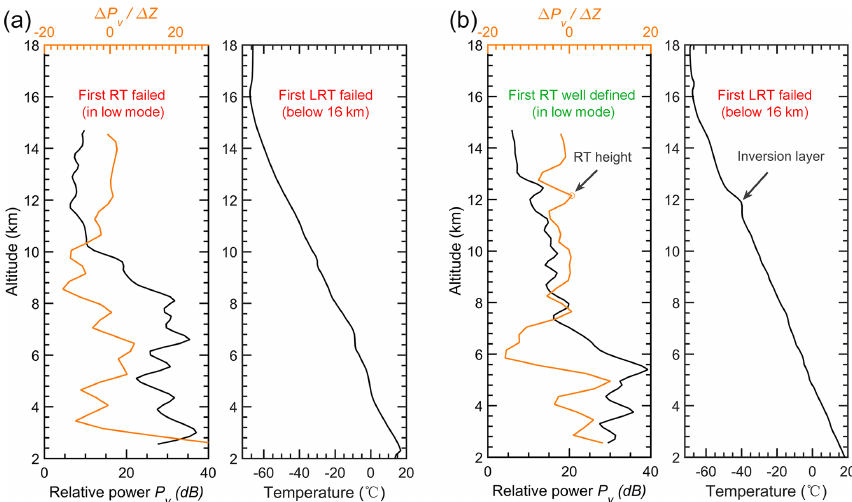
Figure 12. Example profiles of radar echo power and radiosonde temperature in which (a) both the RT and LRT definitions fail due to the continuing decrease in temperature at 00:00UTC (coordinated universal time) on 7 July 2012 and (b) the temperature inversion layer that failed to meet the LRT definition but was well defined in RT definition at 12:00UTC on 2 August 2012. Please note that we only consider the conditions below